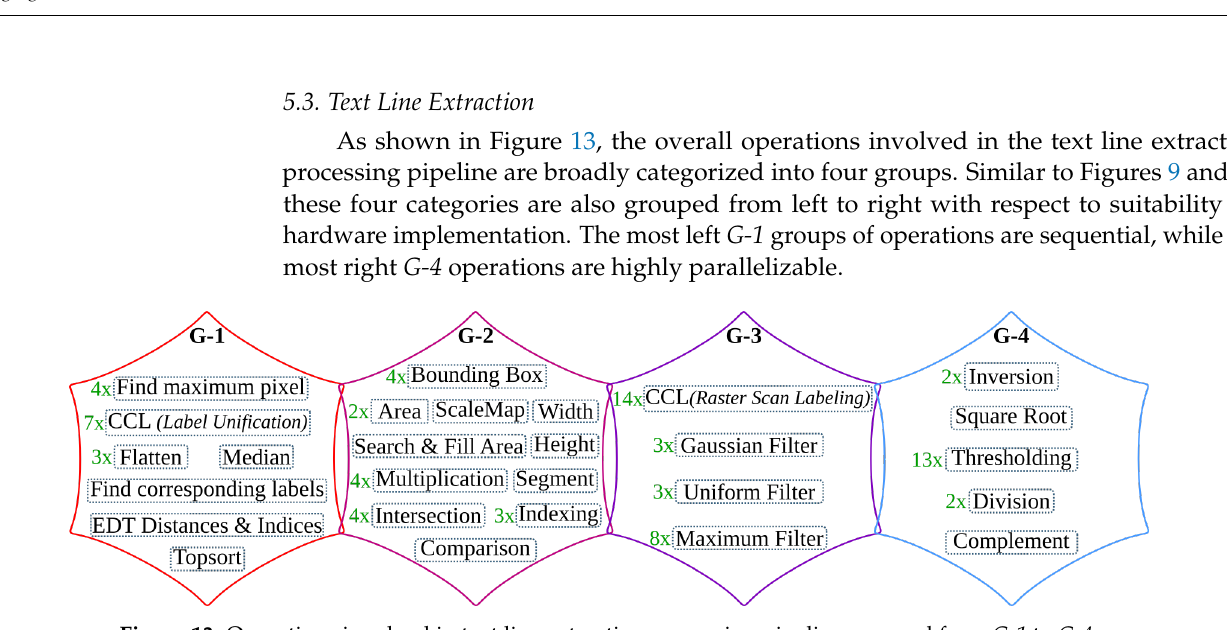
Figure 13. Operations involved in text line extraction processing pipeline grouped from G-1 to G-4